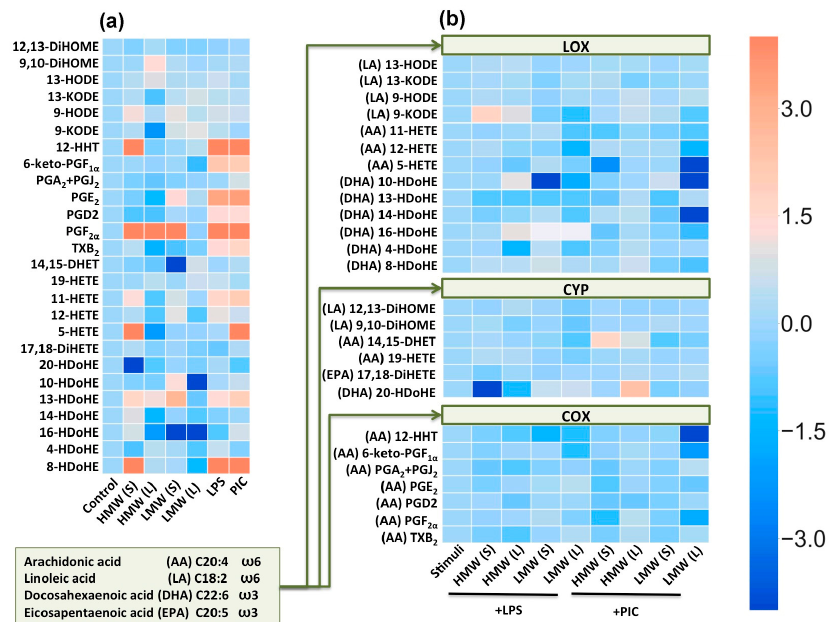
Figure 3. Heatmap representation of oxylipin production of n-6 and n-3 fatty acid-derived lipid mediators. ( a ) Astrocytes were treated with the high molecular weight hyaluronic acid (HMW, 450 µ g / mL) and low molecular weight hyaluronic acid (LMW, 450 µ g / mL) for 0.5 or 48 h, and LPS (100 ng / mL) or PIC (10 µ g / mL) for 4 h. Concentrations of oxylipins in supernatants were measured using UPLC-MS / MS. The heat map shows relative amounts of each lipid mediator compared to the control. The horizontal axis indicates the stimuli, while the vertical axis indicates the relative amount (ln) of each lipid mediator. ( b ) Astrocytes were pretreated for 0.5 or 48 h with HMW (HMW, 450 µ g / mL) and (LMW, 450 µ g / mL) HA and then stimulated with LPS (100 ng / mL) or PIC (10 µ g / mL) for 4 h. The heat map shows relative amounts (ln) of each lipid mediator compared to the LPS and PIC-stimulated cells respectively. Values represent the mean from three independent experiments. Metabolites were divided into: Lipoxygenase (LOX), cyclooxygenase (COX) and cytochrome (CYP) pathways involved in their synthesis.